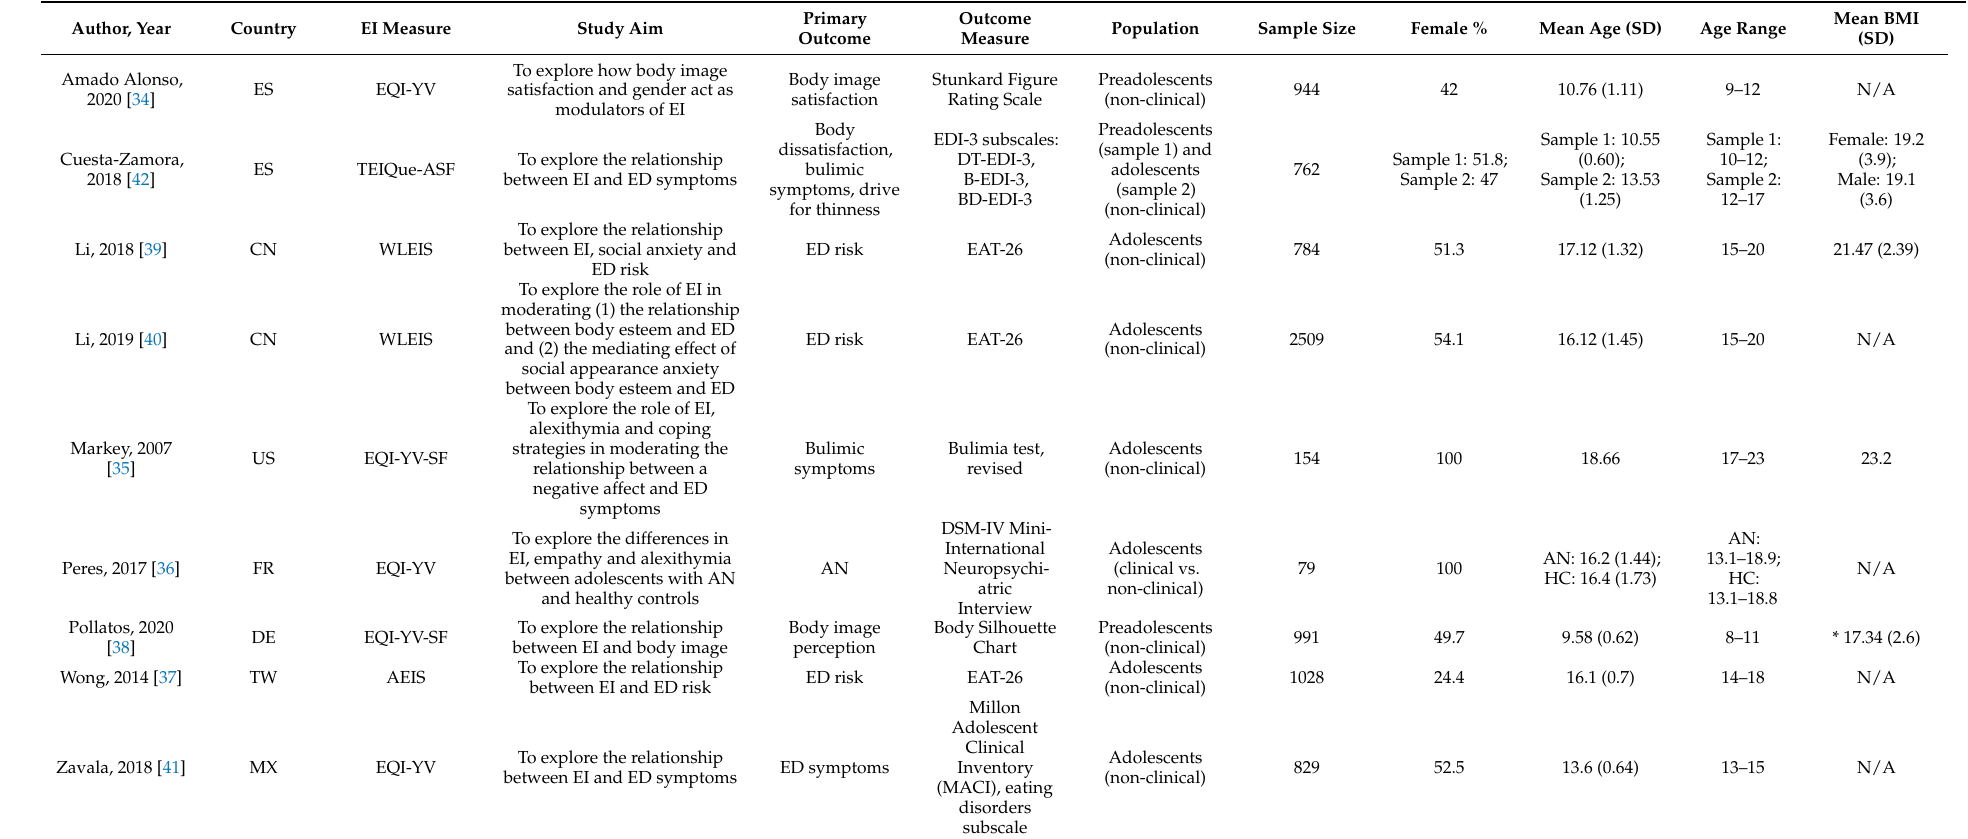
Table 1. Description of the included studies ( n =